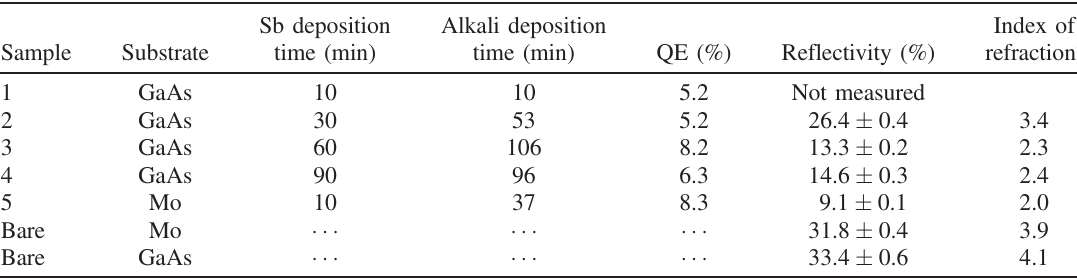
TABLE I. Fabrication details and measurements of manufactured photocathodes.